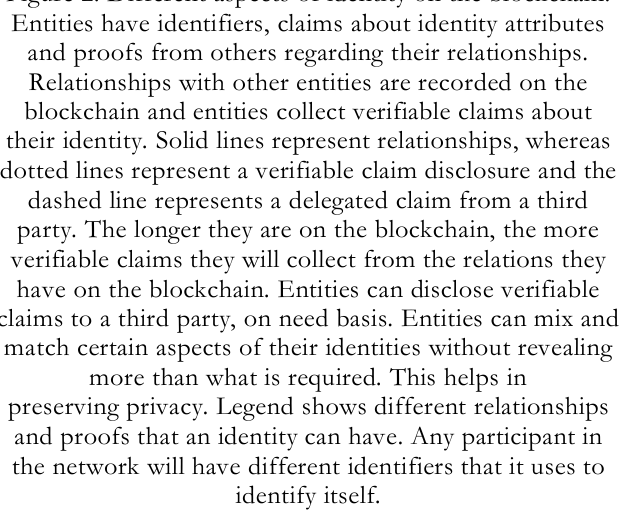
identify itself.